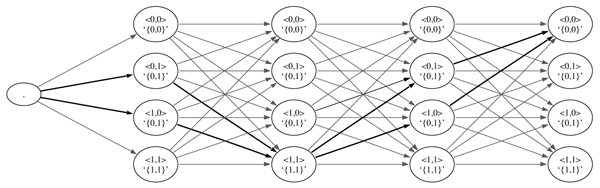
A hidden Markov model over genotypes. Possible paths for genotype observation '{0, 1}', '{1, 1}', '{0, 1}', '{0, 0}' are highlighted. The corresponding haplotype pairs are {(0100, 1110), (0110, 1100), (1100, 0110), (1110, 0100)}.